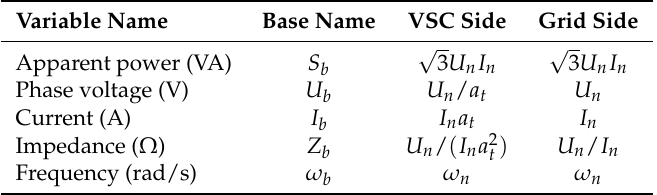
Table 1. Base values used in this